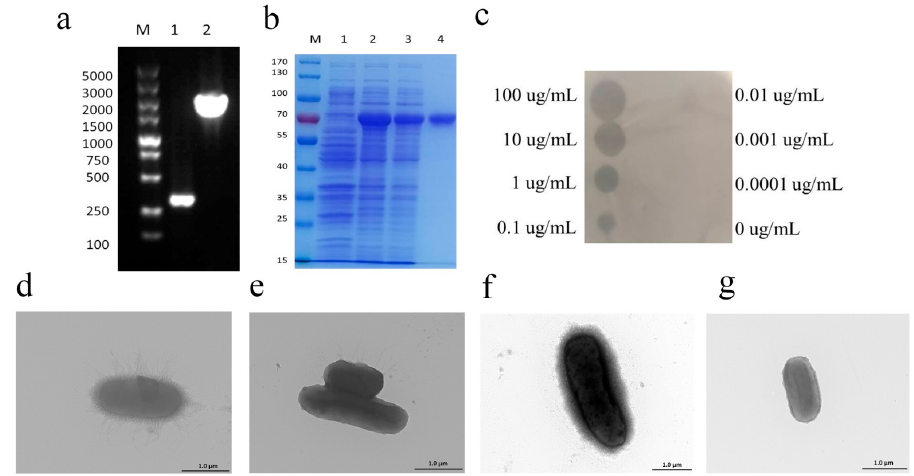
Figure 5. The expression and activity test of recombinant depolymerase Dep_ZX1. ( a ) Agarose nucleic acid electrophoresis picture of Dep_ZX1 expression plasmid; 1: negative control, pET-28a; 2: positive plasmid, pET-28a-TFP. ( b ) The SDS-PAGE image of purified depolymerase Dep_ZX1; 1: E. coli BL21(DE3) carrying pET-28a plasmid expressed for 24 h; 2: E. coli BL21(DE3) strain carrying pET-28a-TFP plasmid expressed for 24 h; 3: unpurified recombinant Dep_ZX1; 4: purified recombinant Dep_ZX1. ( c ) Spot tests of purified Dep_ZX1 on K. pneumoniae 111-2 lawn. Dep_ZX1 with 100, 10, 1, 0.1, 0.01, 0.001, and 0.0001 µ g/mL (labeled on the left or right side of the spot) were measured for anti-capsule activity. ( d ) TEM picture of logarithmic K. pneumoniae 111-2. ( e ) TEM picture of logarithmic K. pneumoniae 111-2 treated with Dep_ZX1. ( f ) TEM picture of stationary growth K. pneumoniae 111-2. ( g ) TEM picture of stationary growth K. pneumoniae 111-2 treated with Dep_ZX1.